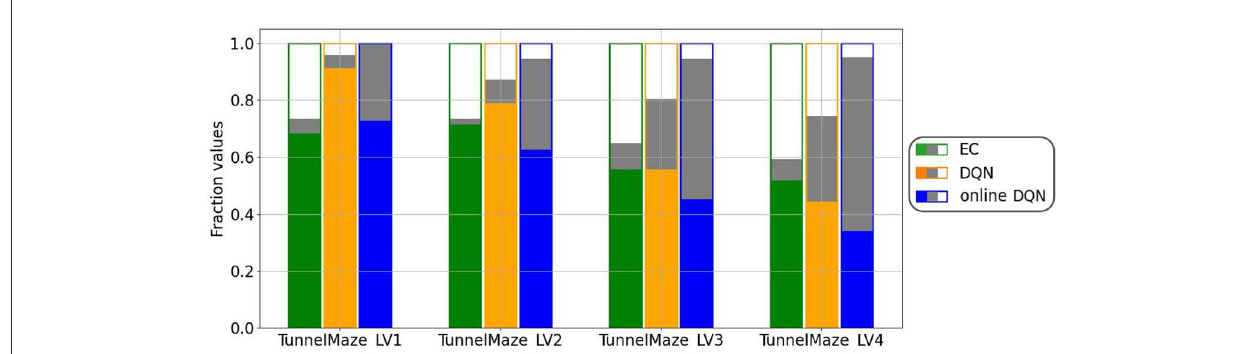
FIGURE9 Agents that learned faster explored less. For each algorithm-maze combination, bars show the fraction of states that were never visited during training (white fill); from which the agent will navigate to the goal, i.e., solution states (green/orange/blue fill); and were visited at least once during training, but from which the agent will not reach the goal (gray fill). The visited states were collected from the training over 500 trials and the solution states from one test trial per state after the training. The results represent an average over 50 runs.